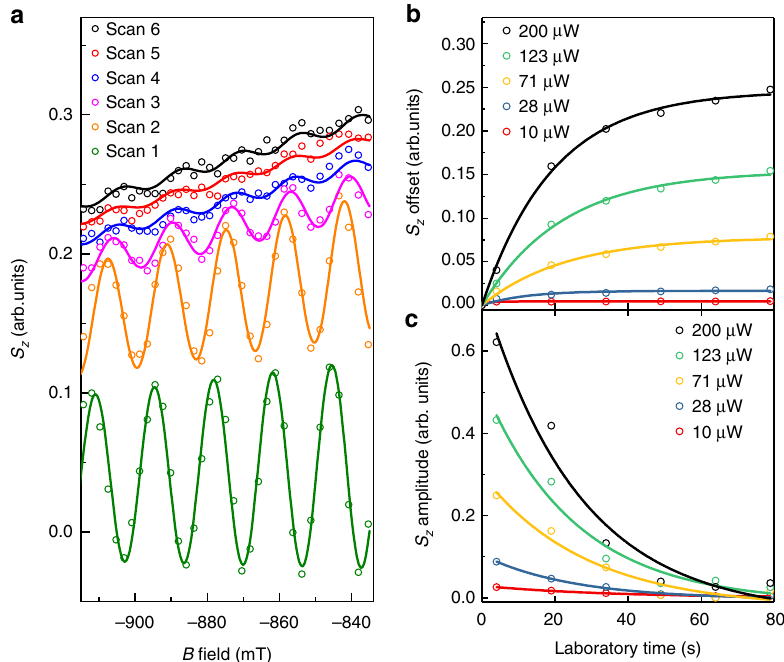
Fig. 3 Build-up of mode-locking. a B - fi eld dependent Kerr signal at t = − 15 ps for six scans taken at different times after depolarization of the nuclear spin polarization (difference between each scan is 15 s). An increase in offset or decrease in amplitude is a measure for mode-locking. b , c Extracted offset and amplitude of the oscillations in B from the fi t in ( a ). Data are shown for different pump powers and a fi xed probe power of 10 µ W. The characteristic offset build-up time or amplitude decay time is pump power independent and is extracted from the fi t to be 25